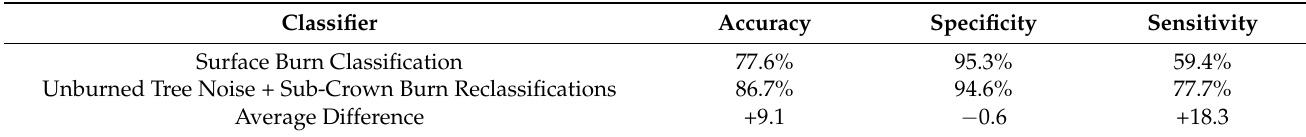
Table 6. Average Validation Data Results across all